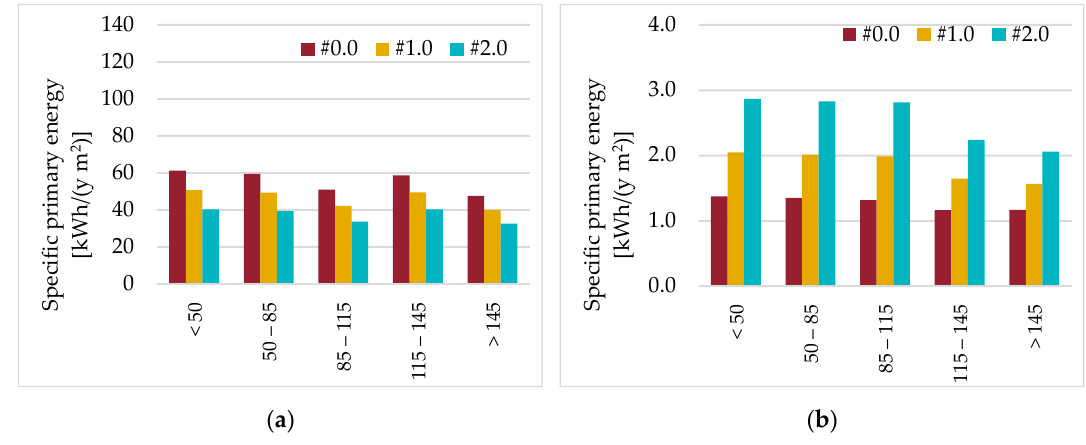
Figure 13. Naples: Specific primary energy consumption. ( a ) Heating; ( b ) cooling.